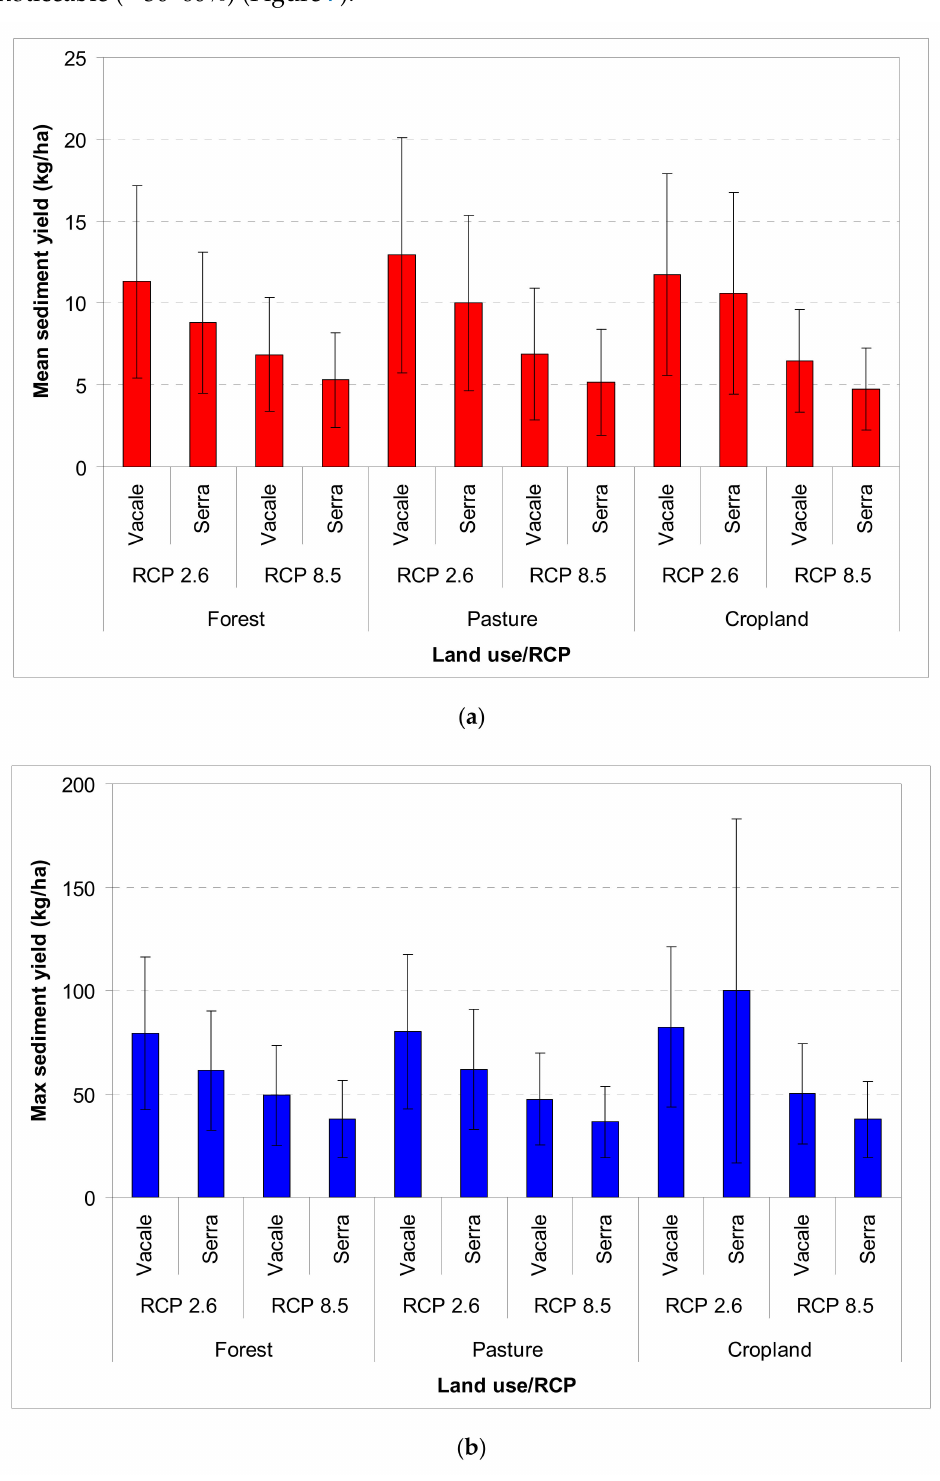
Figure 7. Mean ( a ) and maximum ( b ) values of sediment yield simulated by the SWAT model in unregulated (Serra) and regulated (Vacale) subcatchments (Calabria, Southern Italy). All differences among land use, RCPs, and subcatchments are not significant after Tukey’s test at p < 0.05. The combined analysis of the effects of land-use changes and climate changes shows positive or negative variations of mean and maximum sediment yield, and these